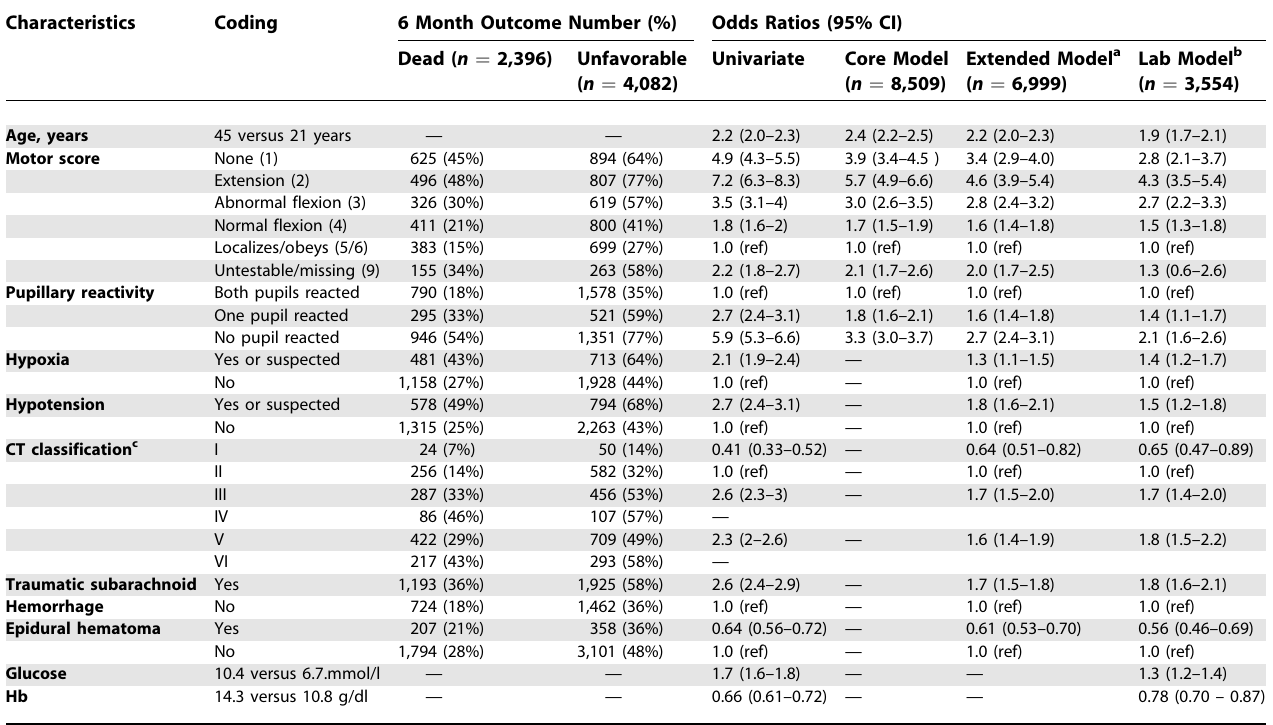
Table 2. Associations between Predictors and 6-Month Outcome in the IMPACT Data ( n ¼ 8,509)